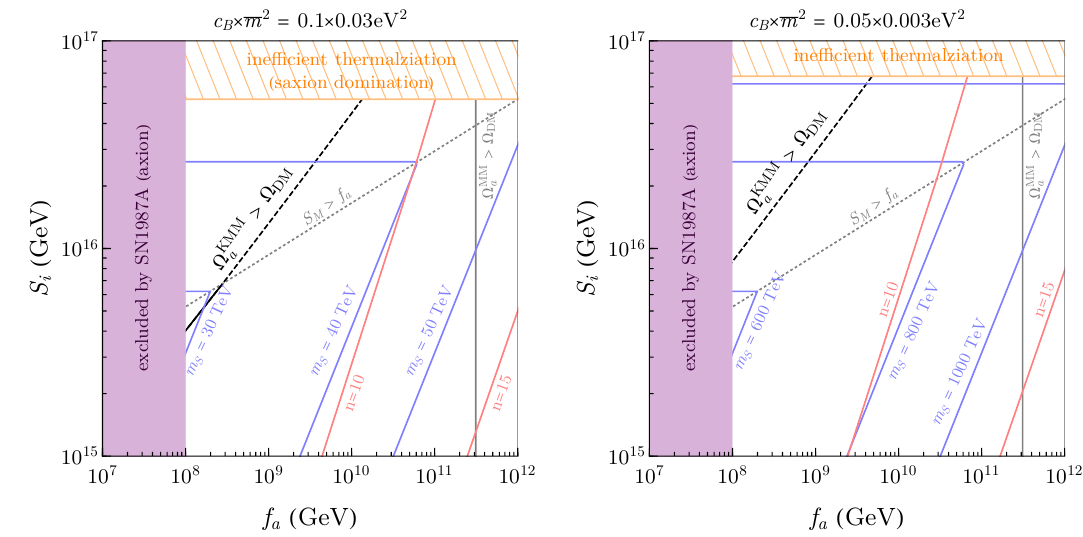
Figure 5 . Parameter space compatible with the observed baryon asymmetry for nearly quadratic potentials in the case without entropy production for N DW = 1 . Values of m S that yield the observed baryon asymmetry are shown by blue contours. Axions account for the observed dark matter via either parametric resonance or kinetic misalignment along the black solid line, while only kinetic misalignment is viable along the black dashed line. We fix (cid:15) = 0 . 25 , which affects the black (both solid and dashed) and pink solid